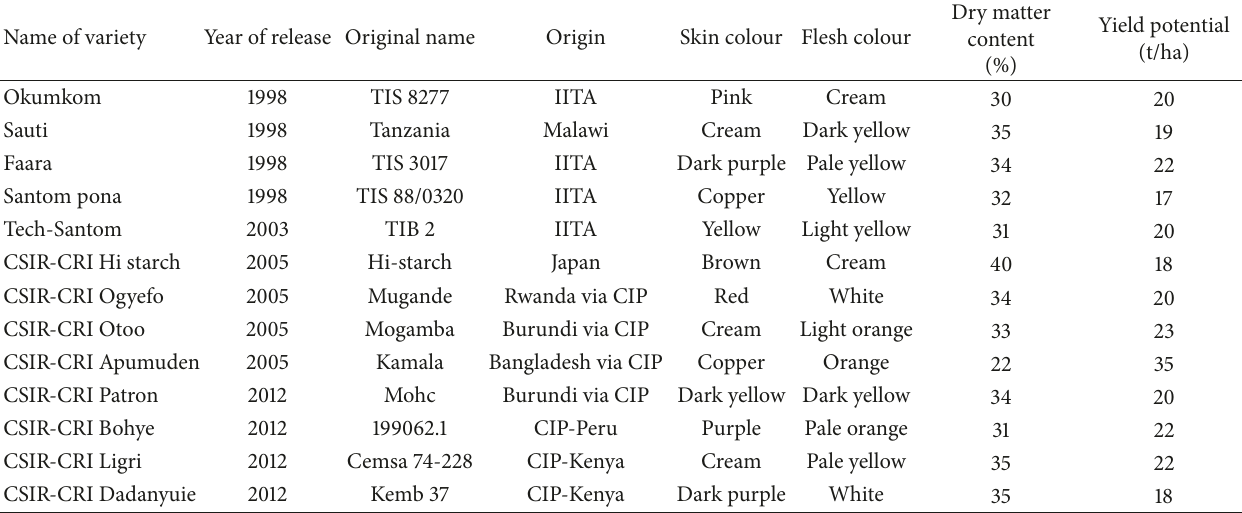
Table 9: Description of some improved cultivars of sweet potato in